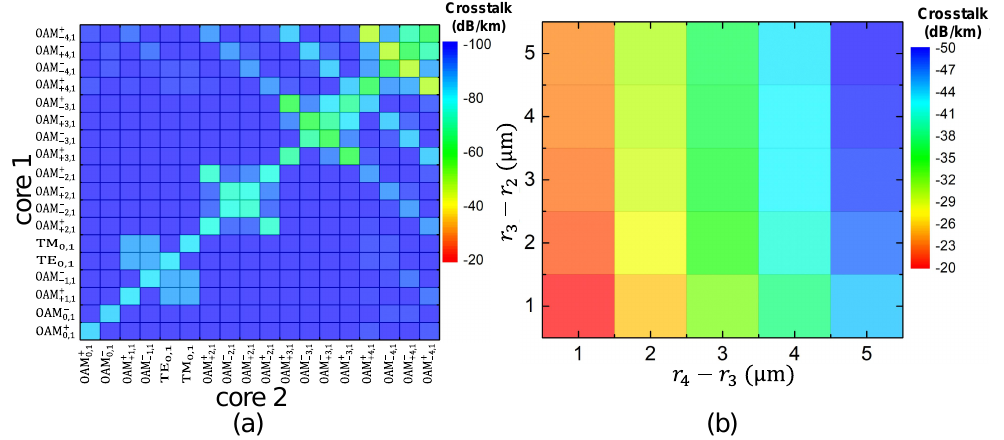
Figure 14. Inter-core crosstalk analysis at the wavelength of 1550 nm when the core-to-core interval is 40 µ m. ( a ) The crosstalk between modes in two ring cores with the parameters r 1 = 4.95 µ m, r 2 = 9 µ m, r 3 = 11 µ m, r 4 = 16 µ m, ∆ co = 1%, ∆ ce = 0%, and ∆ tr = − 0.7%. ( b ) The variation of crosstalk between OAM + + and OAM + − in two identical adjacent cores versus the core-trench gap 4,1 4,1 ( r 3 − r 2 ) and the trench width ( r 4 − r 3